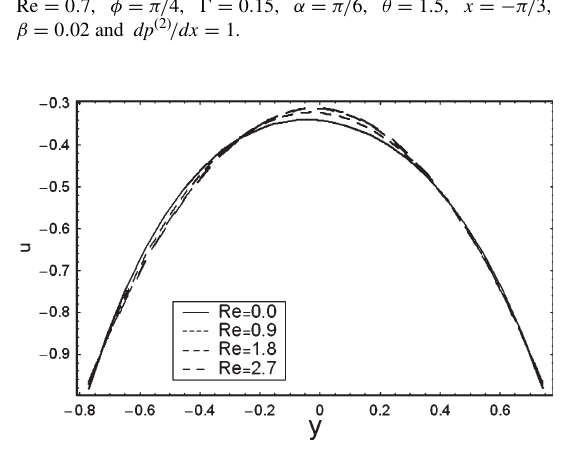
Fig. 15. Effect of the Reynold number Re on the variation of longi- tudinal velocity u plotted for a = 0 . 3, b = 0 . 5, d = 0 . 9, Fr = 1 . 2, φ = π/ 4, (cid:15) = 0 . 2, α = π/ 6, θ = 1 . 1, x = − π/ 3, β = 0 . 02 and dp (2) /dx = 1.